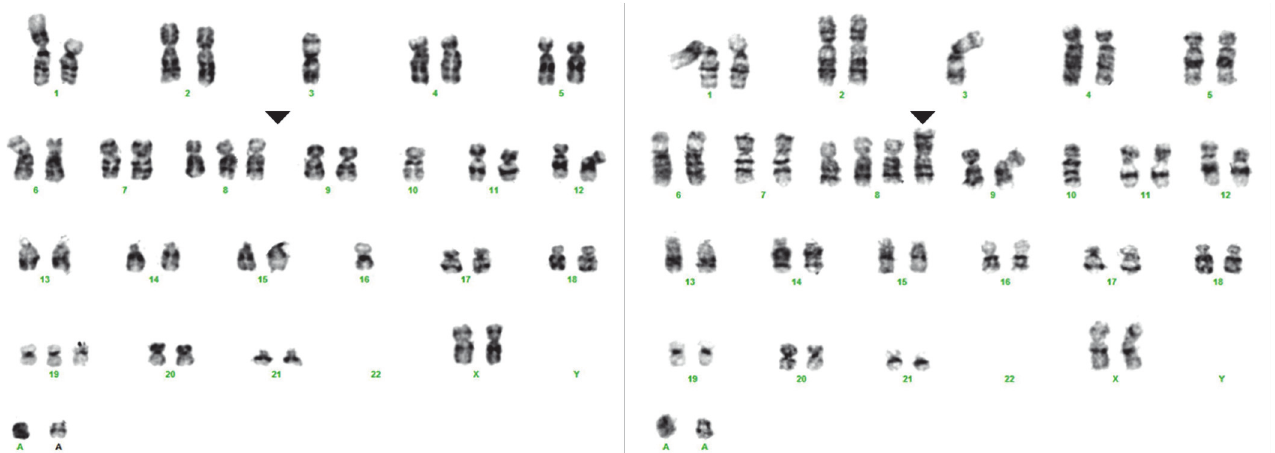
Fig 4. Chromosome 8 heterogeneity in UM 07 – 050. One clone presents trisomy 8 (left) while the other clone presents trisomy 8 (triangle) in combination with isochromosome 8q (right). Besides chromosome 8, chromosome 1, 3, 10 and 22 showed clonal abnormalities. Two markers (A) on the bottom indicate the shared origin of these clones.